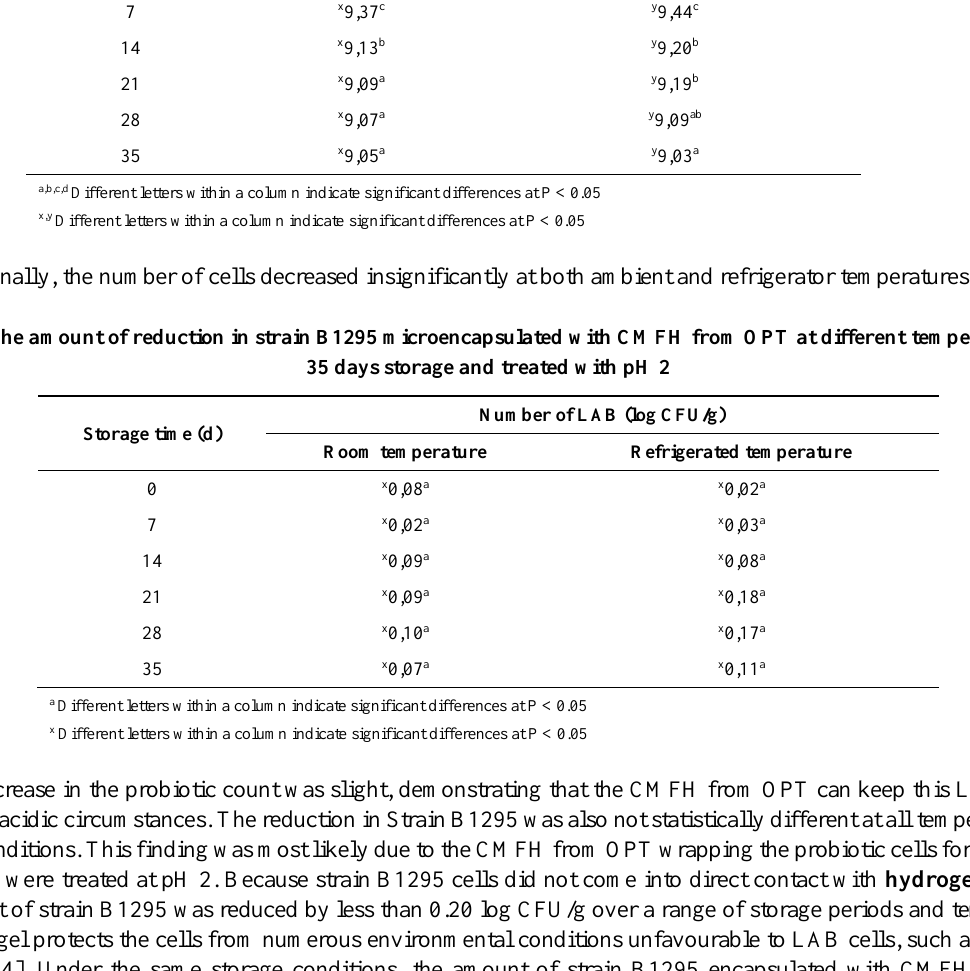
Table 5. Number of strain B1295 microencapsulated with CMFH from OPT at different temperatures for 35 days storage and treated at pH 2 Number of LAB (log CFU/g) Storage time (d) Room temperature Refrigerated temperature